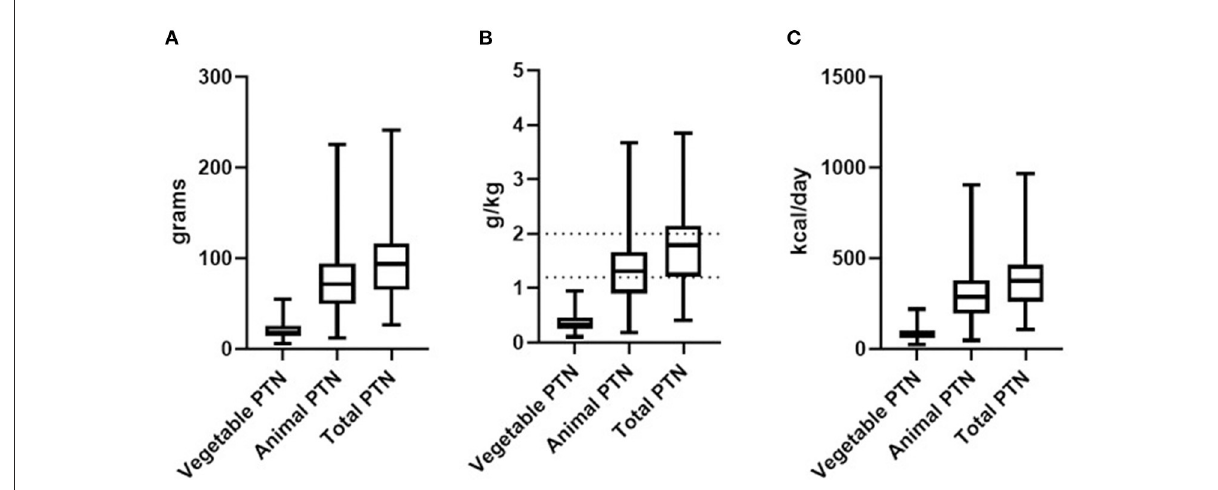
FIGURE1 Daily protein intake (g) (A) , daily protein intake per kilogram of body weight (g/kg) and the ADA (2) recommendation range for protein (1.2–2.0 g/kg/day) (B) , and daily energy intake from protein (C) of adolescent athletes according to the food source of protein. Data expressed as median, minimum, and maximum. Dotted lines: Recommendation range (1.2–2.0